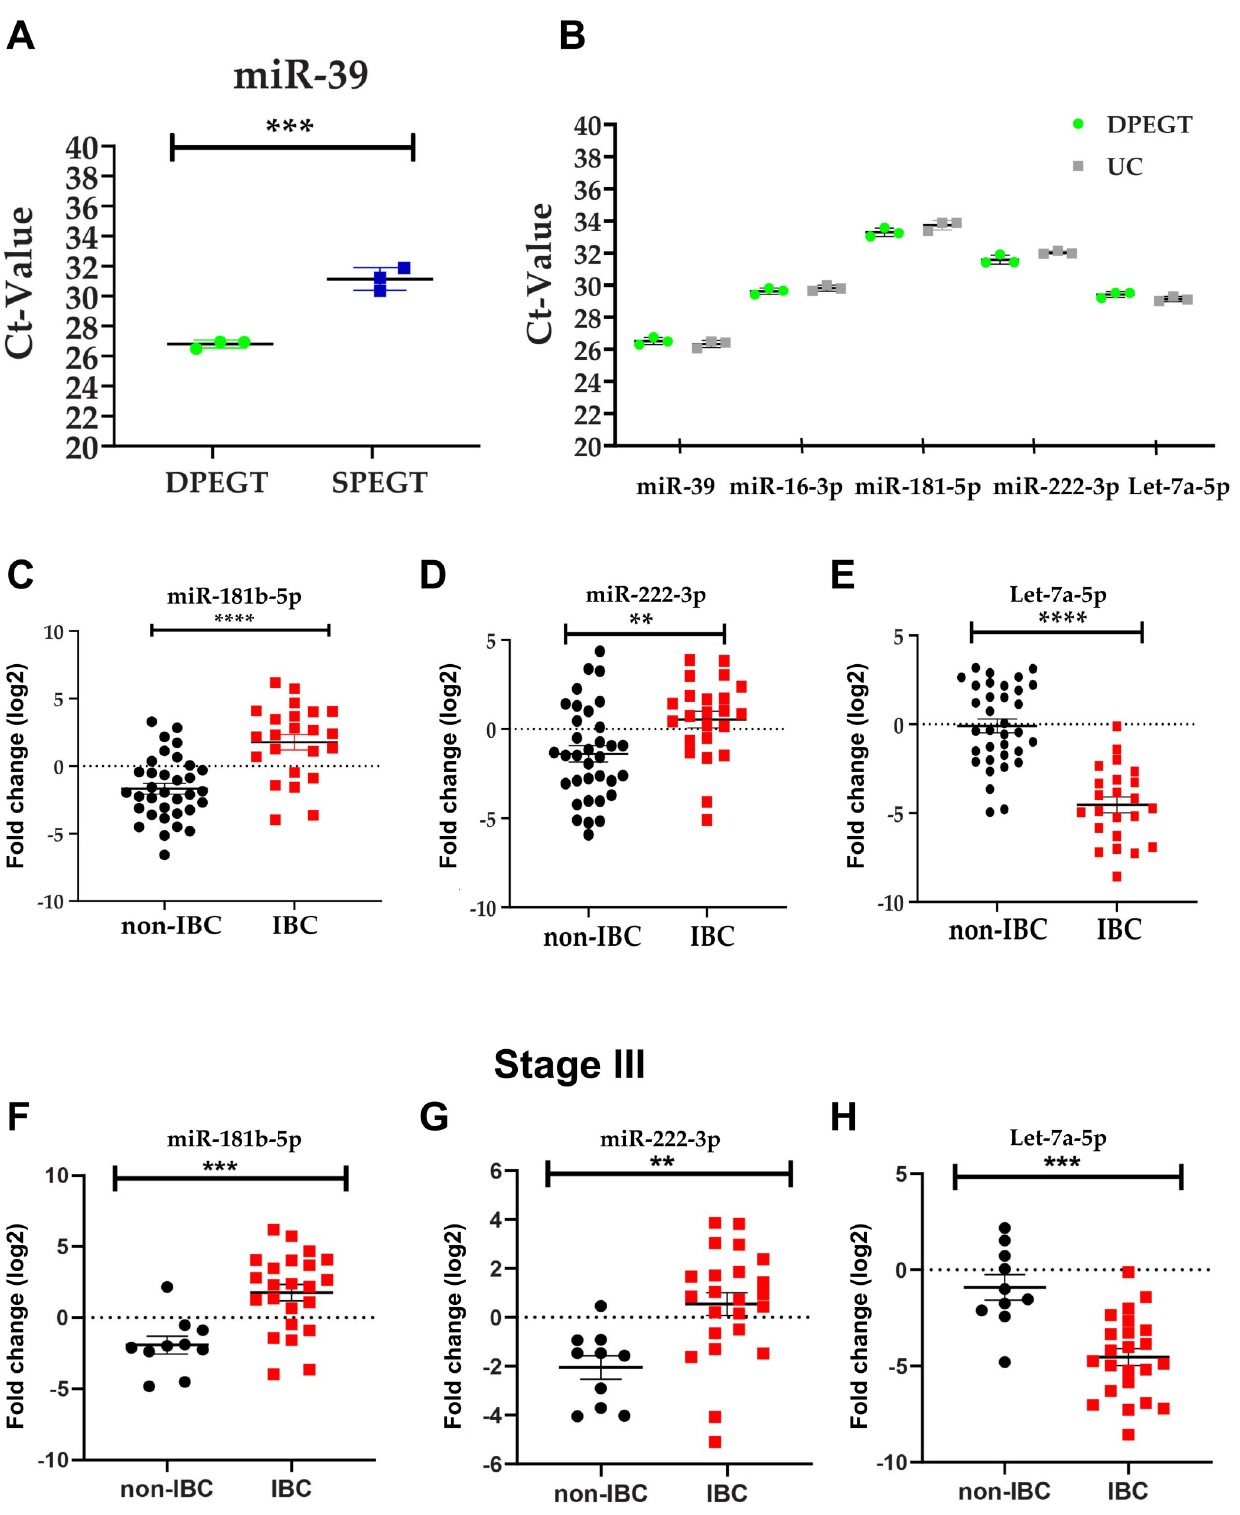
Fig 5. Expression levels of miR-181b-5p, miR-222-3p and let-7a-5p in enriched plasma sEVs. Total RNA of sEVs isolated from patients with non-IBC and IBC, and normal volunteers was reverse transcribed into cDNA and miRNA expression levels were quantified using specific miRNAs primers. (a) Ct values of spike in miR-39. n = 3, ��� p < 0.001 as determined by Student’s t-test. (b) Comparable Ct values of miR-39, miR-16-3p, miR-181b-5p, miR-222-